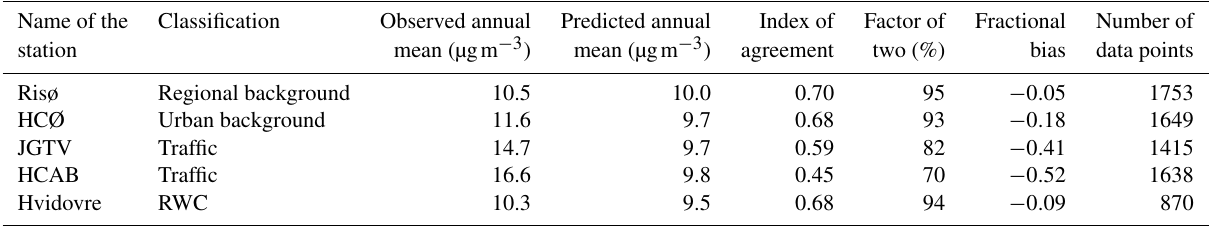
Table C4. Selected statistical parameters for the agreement of predictions and measurements for the daily concentrations of PM 2 . 5 in the Copenhagen area. The results correspond to the period 2013–2017, except for the stations of JGTV and Hvidovre, for which the measurements were started later on (in November 2013 and in June 2015, respectively). RWC stands for residential wood